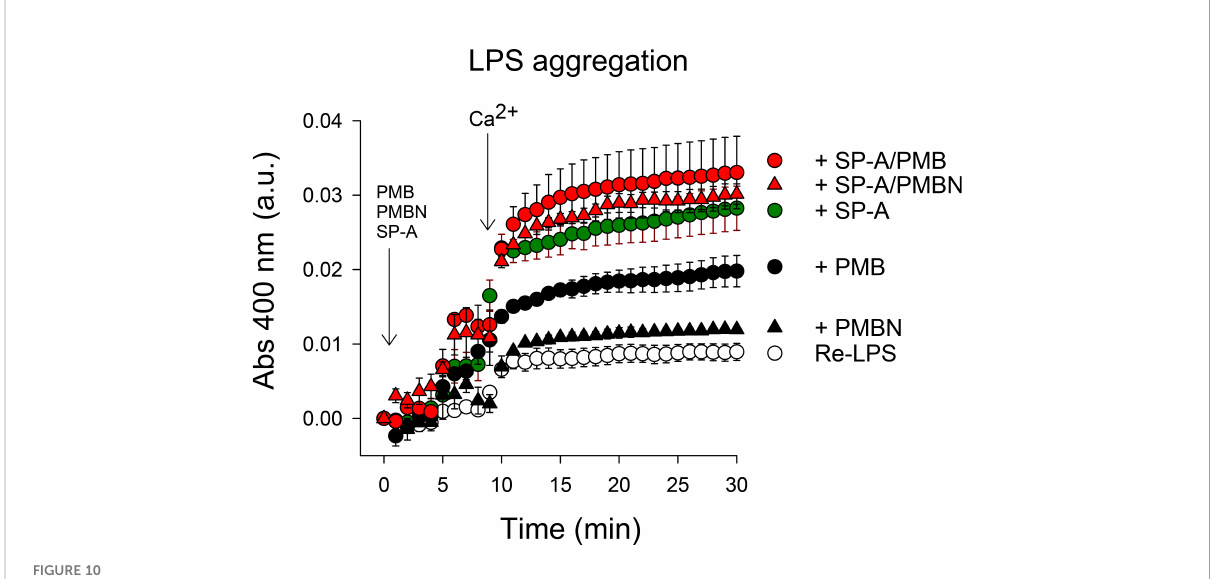
FIGURE 10 LPS aggregation induced by SP-A, PMB, PMBN, and combinations thereof. Ca 2+ -dependent Re-LPS aggregation was studied by measuring the change in absorbance at 400 nm in a Beckman DU-800 spectrophotometer. Re-LPS was prepared at a fi nal concentration of 40 m g/ml in 5 mM Tris-HCl buffer, pH 7.4, containing 150 mM NaCl and 0.1 mM EDTA. The fi nal concentration of SP-A and polymyxins was 20 m g/ml (30 nM) SP- A, 1.5 m g/ml (1.08 µM) PMB, and 2.5 m g/ml (2.59 µM) PMBN. The concentration of Ca 2+ was 2.5 mM. Results are the mean ± SD of three